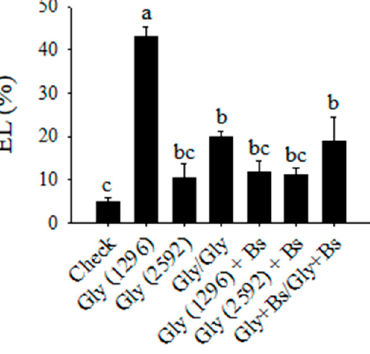
Figure 4. Electrolyte extravasation in plants submitted to different doses of glyphosate, with or without application of B. subtilis BV02. Means followed by the same lowercase letters do not differ according to the SNK test ( p ≤ 0.05).